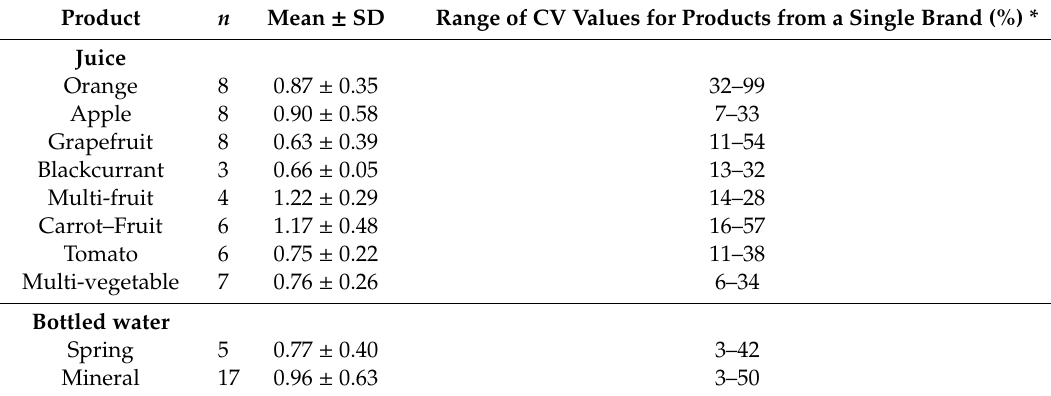
Table 3. Silicon content in beverages (mg / 100